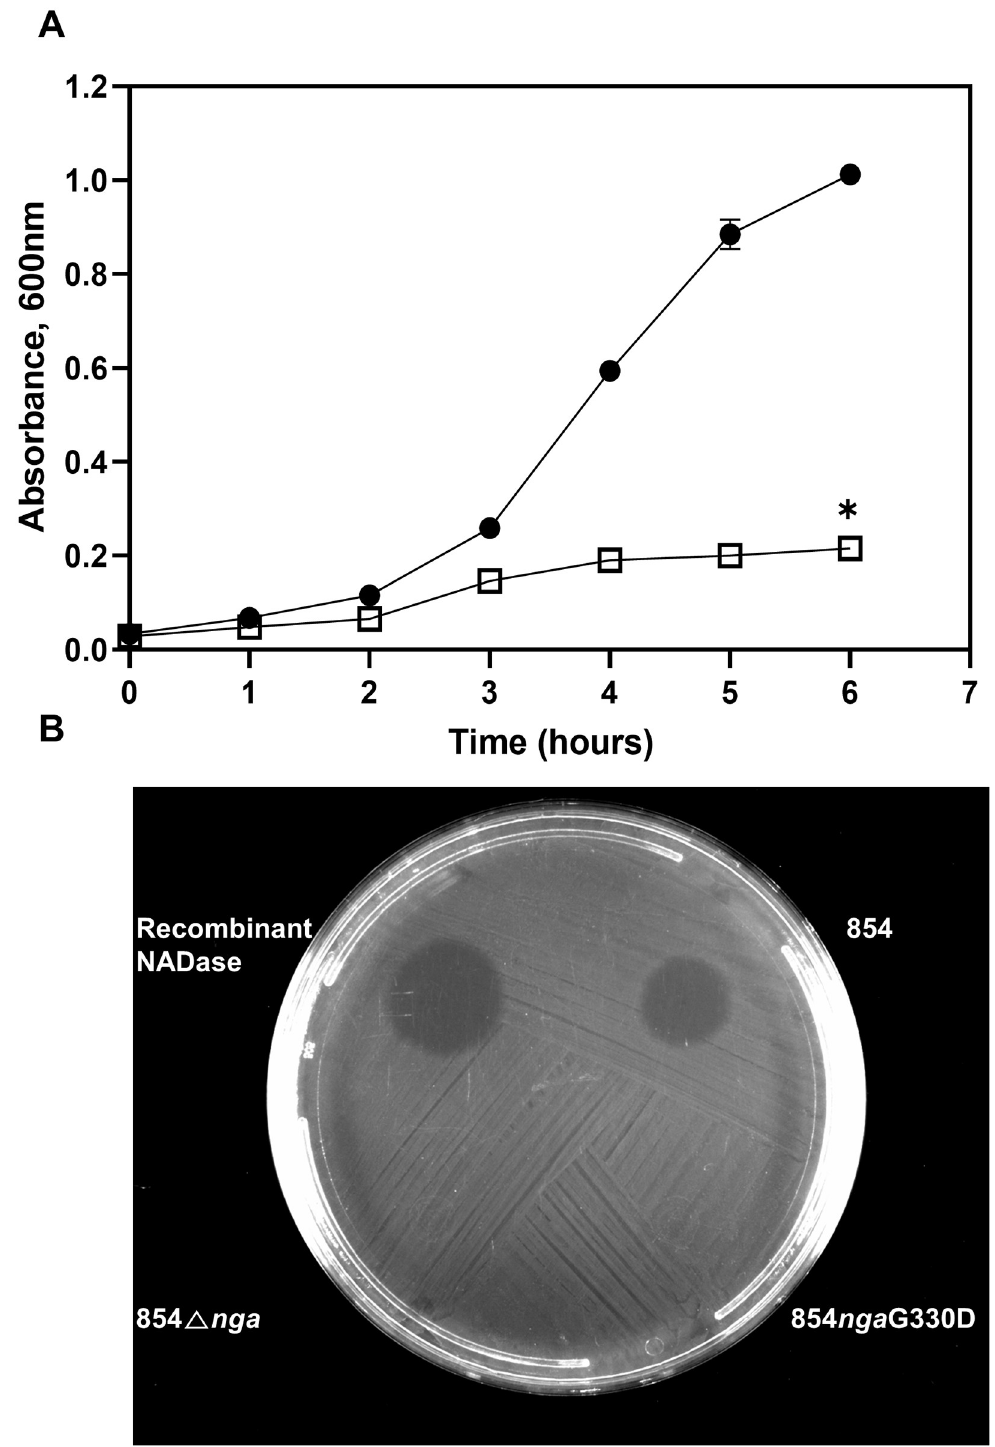
Fig 4. Effect of NADase on H . influenzae . A . Growth of H . influenzae in liquid medium in the absence ( ● ) or presence ( □ ) of recombinant NADase. Growth was inhibited in the presence of NADase ( � P < 0.05). Data are the mean ± SD of three biological replicates (Error bars are < 0.05 and are obscured by plot symbols for all data points except one at 5 hours). B . Bacterial lawn of H . influenzae shows inhibition of growth by recombinant NADase or GAS 854 culture supernatant.